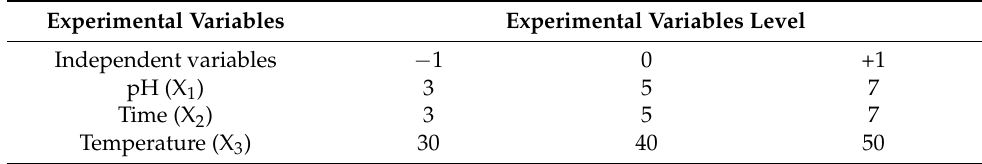
Table 1. Experimental settings of independent process variables. Experimental